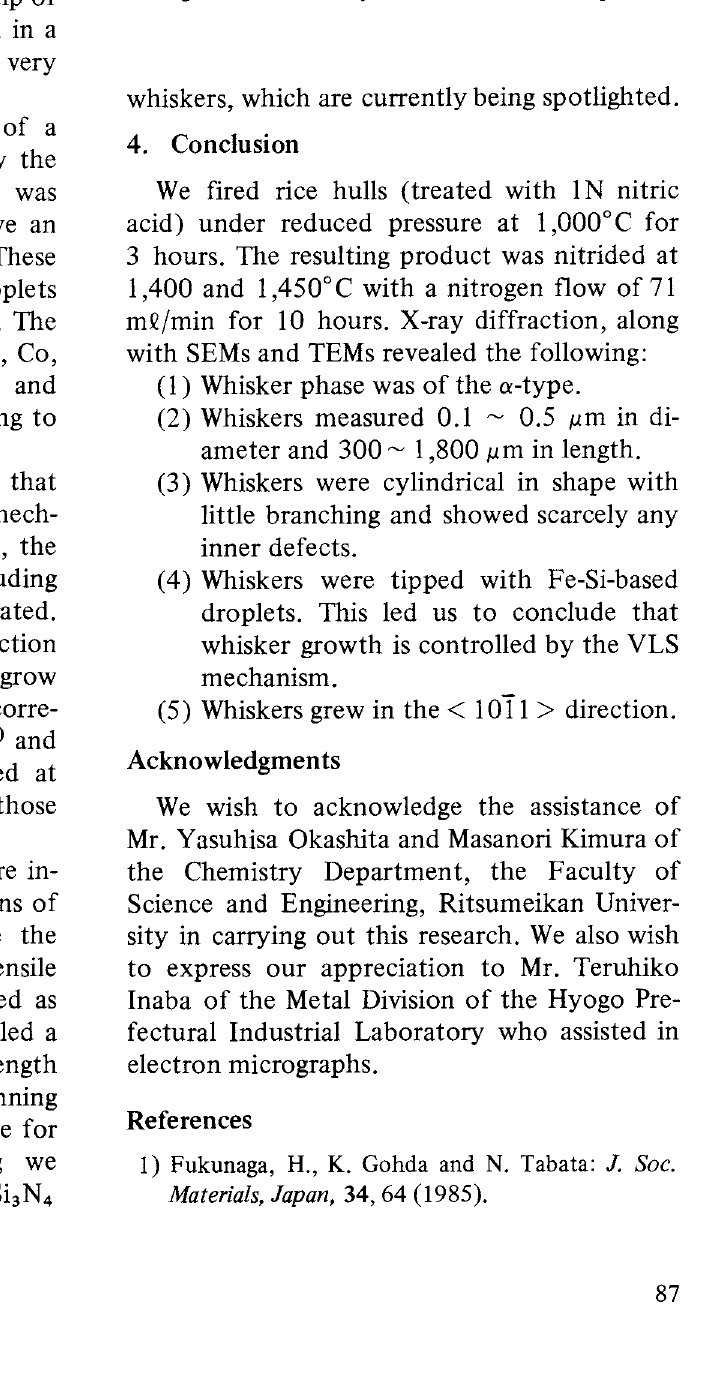
Fig. 10 EDAX analysis of whiskers and